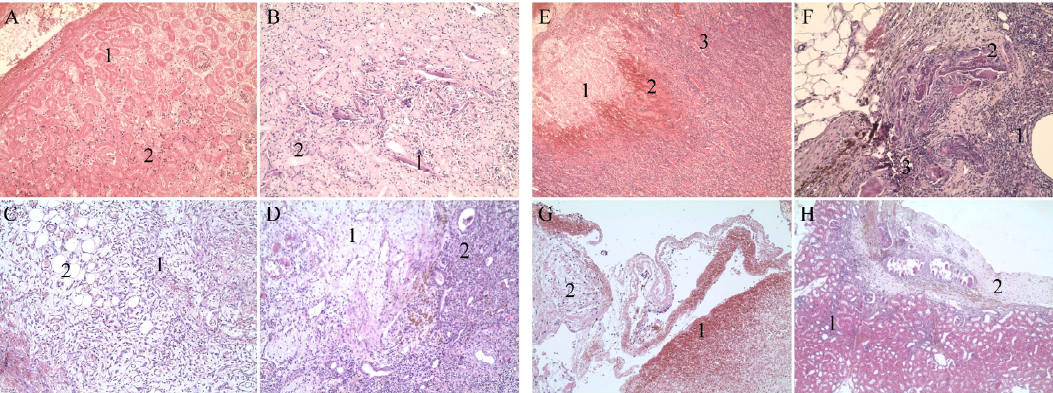
Figure 6. Histological images, H&E. Reference ORC textile: ( A ) Magnification: 100 × ; 3 days—necrotic tissue (1), inflammatory infiltrate (2). ( B ) Magnification 100 × ; 30 days—granuloma around the foreign material (1), chronic inflammatory infiltrate (2). HA / OX textile: ( C ) Magnification 100x; 3 days—vascular granulation tissue in the cutting line (1), adipose tissue (2). ( D ) Magnification 100x; 30 days—regular adequate scarring (1), traces of a delayed inflammation (2). HA / CMC textile: ( E ) Magnification 50 × ; 3 days—tissue necrosis (1), bleeding (2), protein cylinders (3). ( F ) Magnification 100 × ; 30 days—inflammation (1), granuloma (2), traces of a contamination (3). HA / CMC / ET textile: ( G ) Magnification 100 × ; 3 days—presence of a hematoma (1), damaged tissue in the cutting line (2). ( H